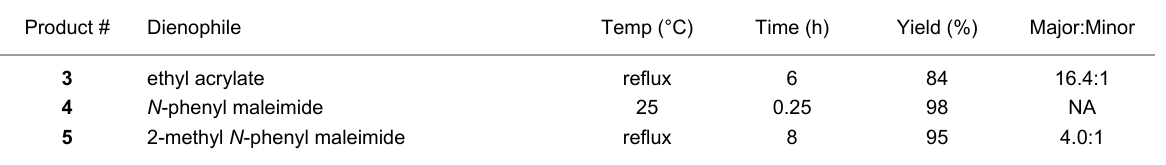
Table 1: Diels–Alder reactions of diene 2 .